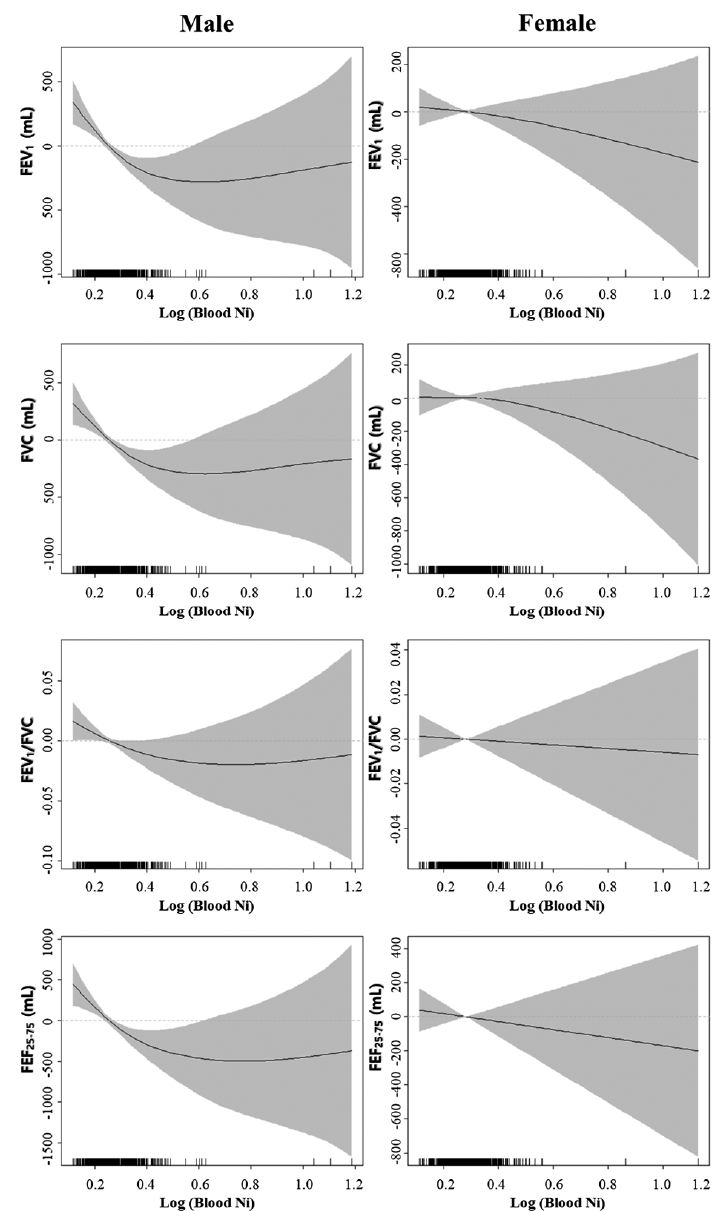
Figure 1. Smoothing plots with a general additive model showing the distribution of pulmonary function profiles by log-transformed blood nickel concentrations in men and women.